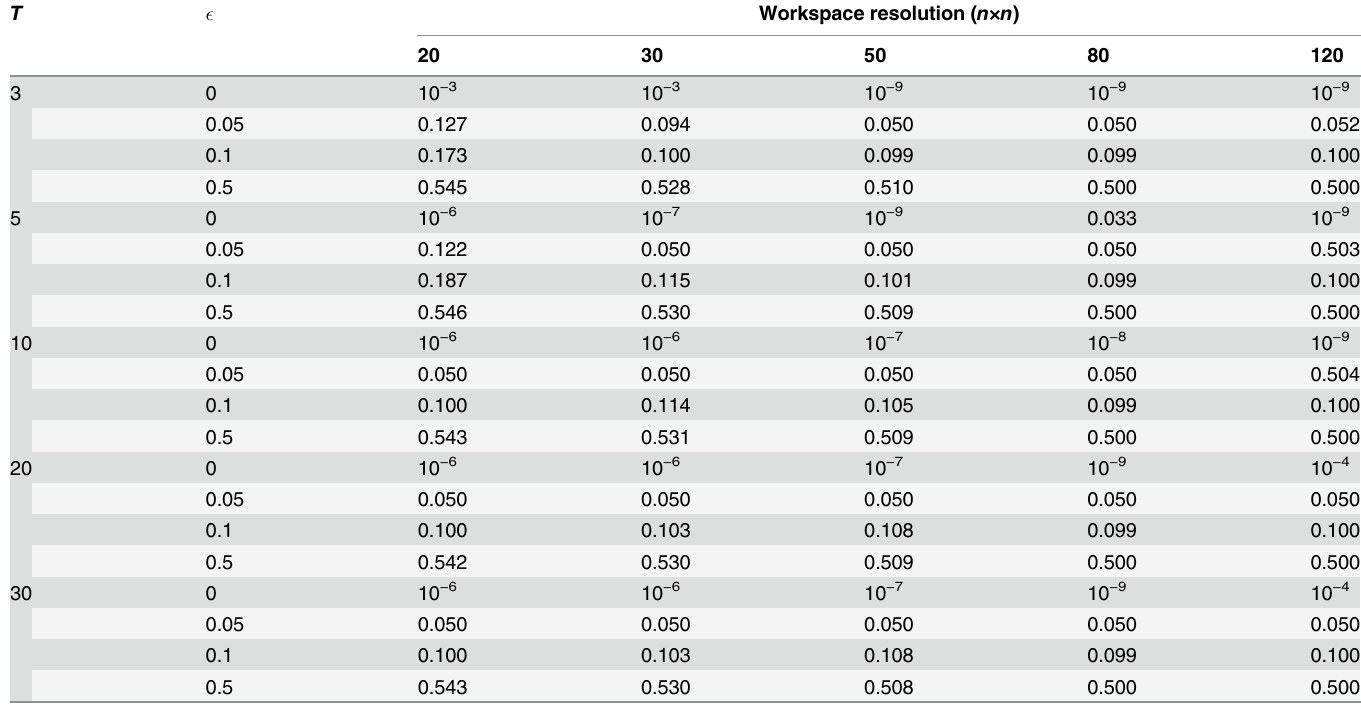
Table 6. Average collision probability p C ( u , M (cid:2) ).